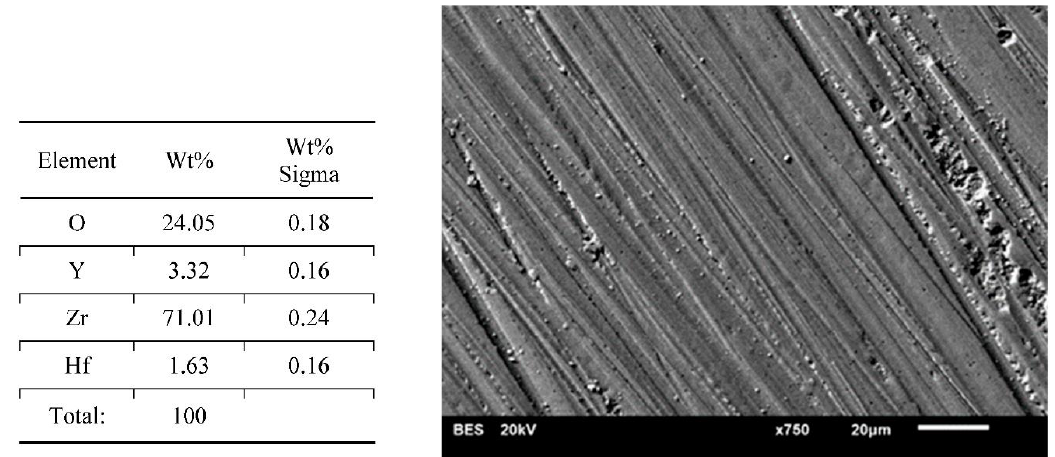
Figure 5. Chemical composition of the presented area and a backscattered electrons image of a sample—wet ground 120 grit paper. Wide features and big arrachments visible. Materials 2021 , 14 , x FOR PEER REVIEW